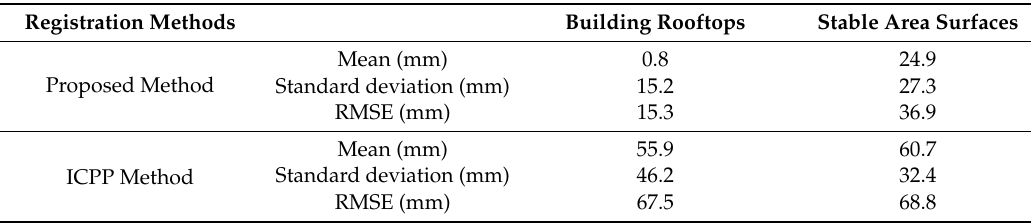
Table 3. The mean, standard deviation, and RMSE of the calculated normal distances results of the proposed registration method and the ICPP for the stable patches between 3D dense image-based point clouds generated in May 2014 and May 2015 of Lethbridge, Alberta study